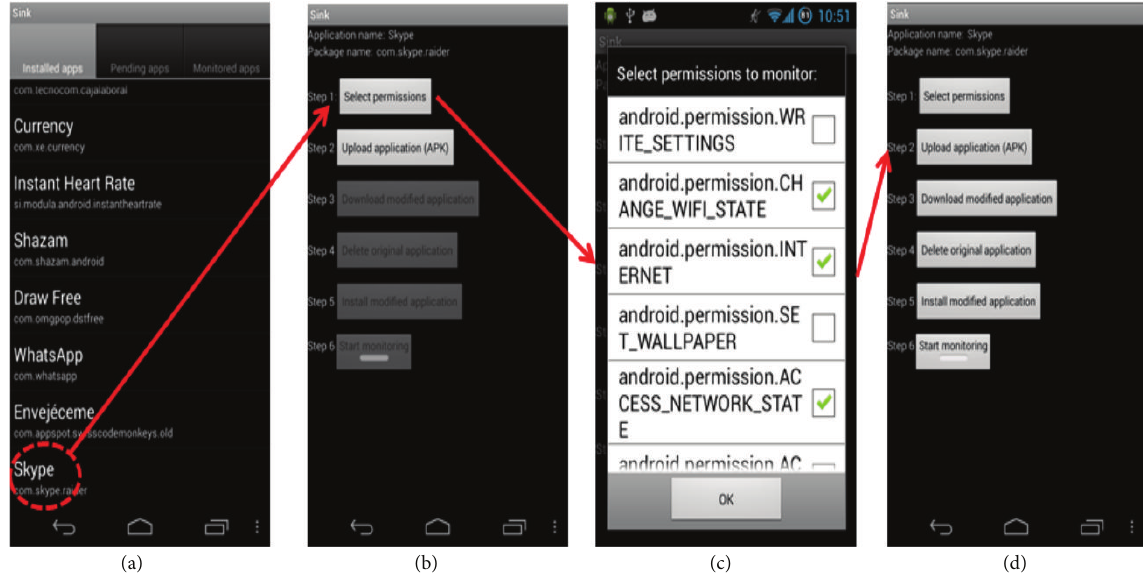
Figure 5: User interface of the Sink. (a) Choosing the application, (b) selecting the menu for permissions, (c) electing the permissions, and (d) steps of the monitoring